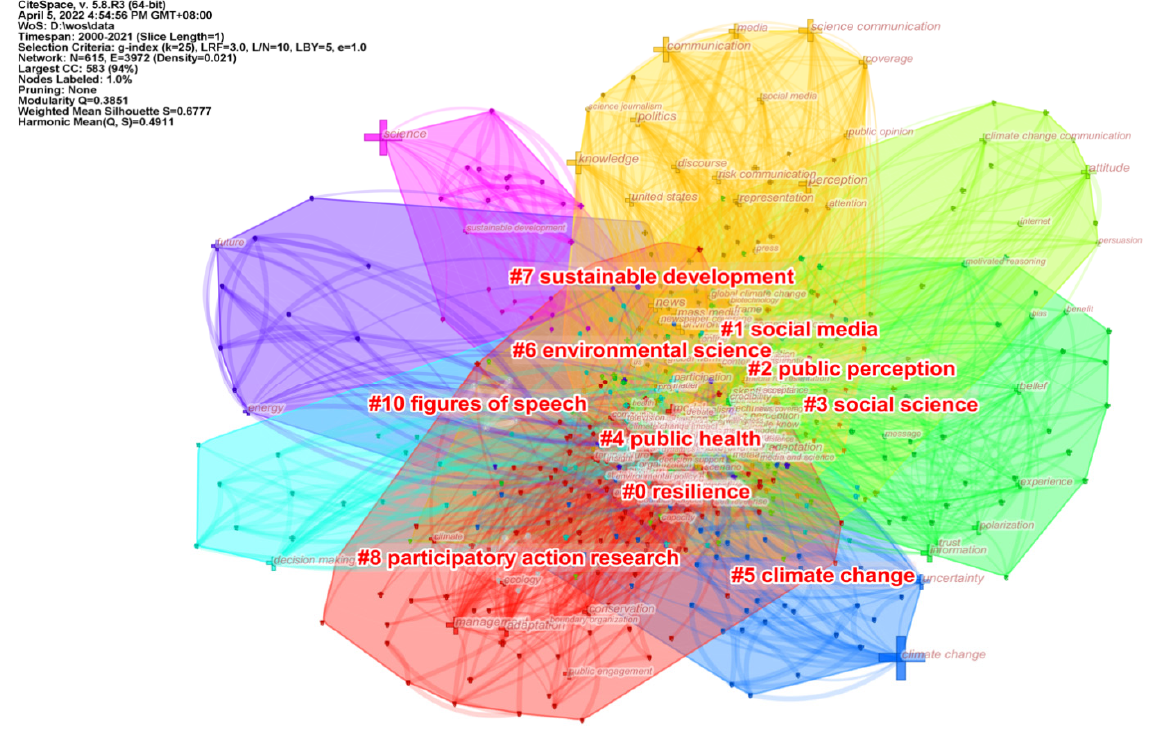
Figure 7. The keyword cluster map for the field of climate change science communication.